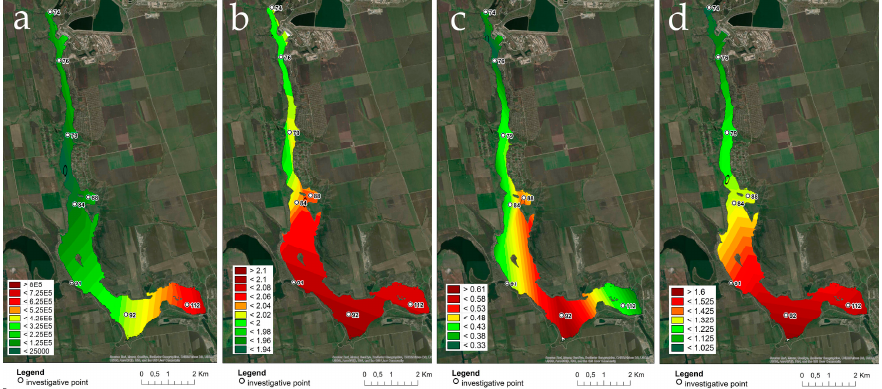
Figure 11. Combined statistical and landscape maps for the Alexandrovskoye reservoir. Abundance ( a ); Index saprobity S ( b ); Ammonia ( c ); Index WESI ( d ). Colors are given for the value amplitude of each mapped variable from green (lower boxes in the legend key) to red (upper boxes in the legend